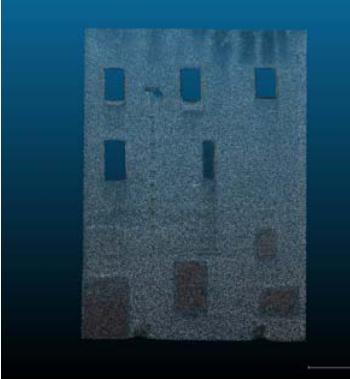
Figure 8: UAV VisualSfm